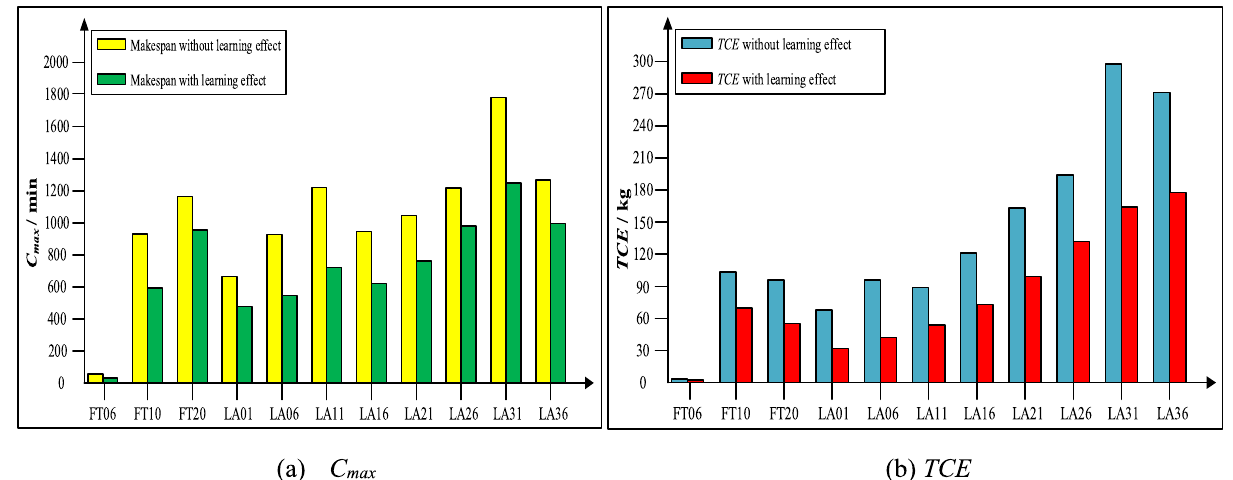
Figure 9. Comparison of C max and TCE with and without the learning effect for 11